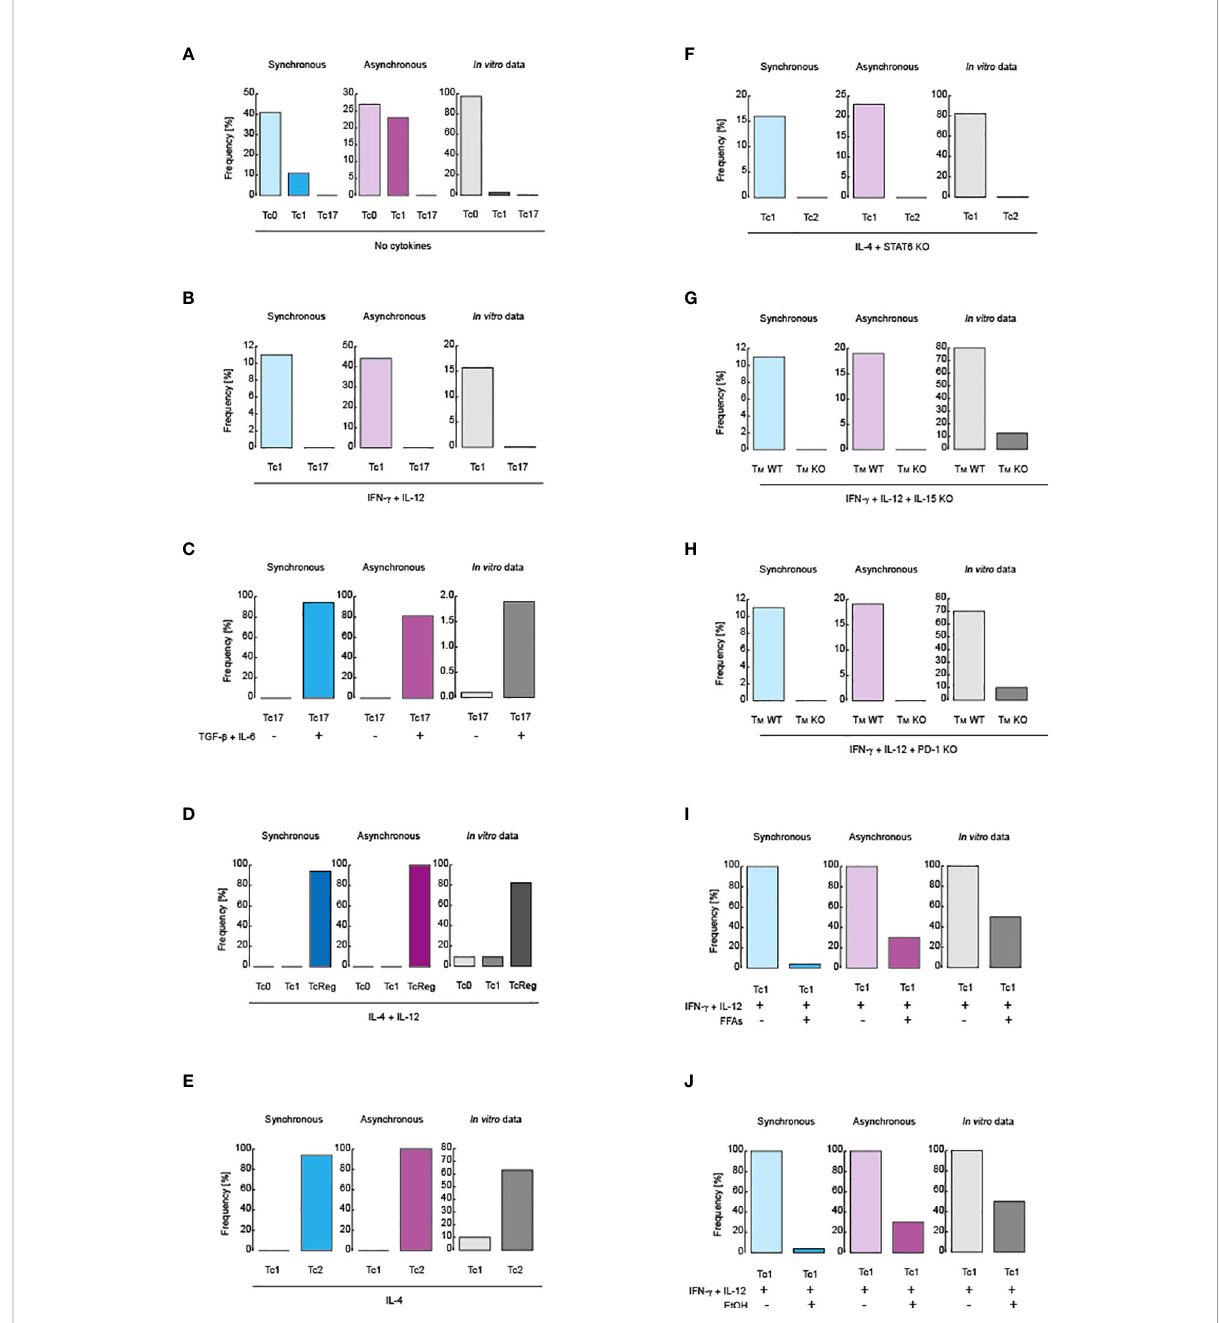
FIGURE 2 Validation of the models. Comparison between simulated data and fl ow cytometry data obtained from in vitro assays. Blue scale of colors is assigned to the synchronous updating scheme, violet scale corresponds to the asynchronous scheme and gray scale is reserved for in vitro data. (A) Cell distribution in the absence of polarizing cytokines. (B) Cell distribution in the presence of IL-12 and IFN- g . (C) Tc17 phenotype in before and after treatment with IL- 6 and TGF- b . (D) Cell distribution in the presence of IL-4 and IL-12. (E) Cell distribution in the presence of IL-4. (F) Phenotype distribution in the presence of IL-4 in knockout for STAT6. (G) Inhibition of IL-15 signaling during IL-12 and IFN- g stimulation. (H) Inhibition of PD-1 signaling in during IL- 12 and IFN- g stimulation. (I) Effect of FFAs during IL-12 and IFN- g stimulation. (J) Effect of alcohol over IL-12 and IFN- g stimulation. All simulations were performed in presence of IL-15, except panel (G)